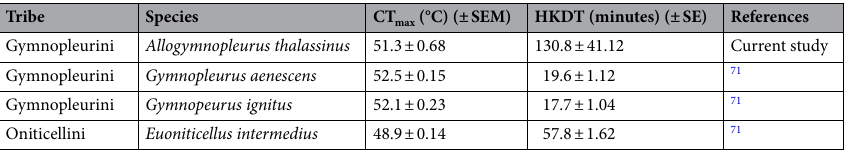
Table 1. The basal CT max (°C) and HKDT (minutes) for Allogymnopleurus thalassinus compared to other diurnal telecoprid species in the same tribe occurring in the same hot and arid environment.